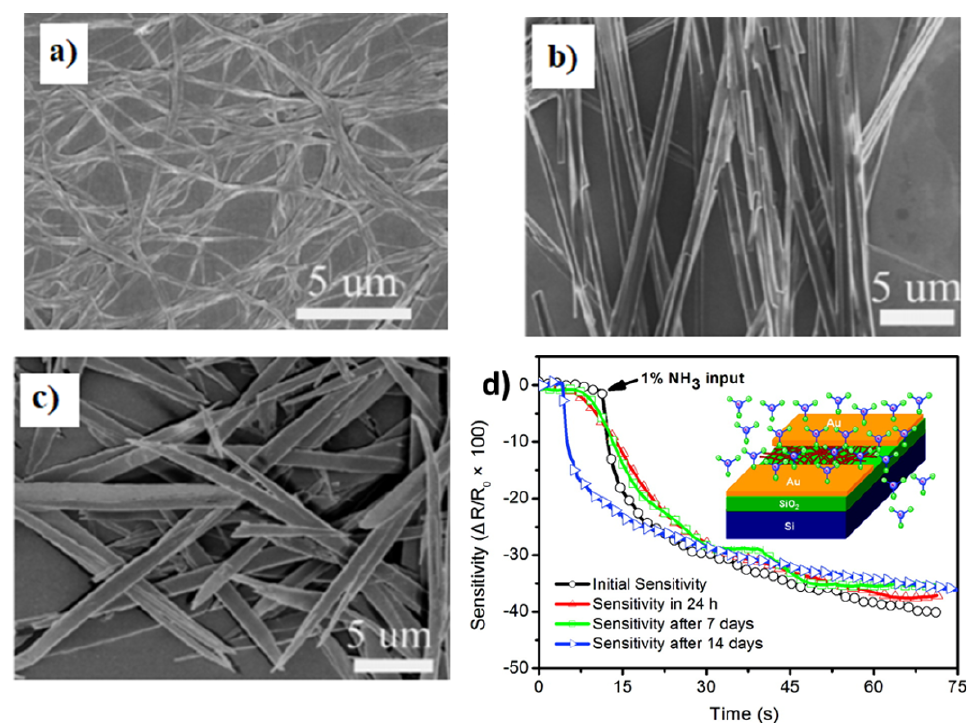
Figure 11. SEM images of ( a ) PDI-C 12 , ( b ) PDI-Br 2 C 12 , and ( c ) PDI-CN 2 C 12 illustrating subtle changes in the nanostructure as a result of bay substitutions. ( d ) Sensitivity curves of PDI-CN 2 C 12 showing the stability of the system over time. Adapted with permission